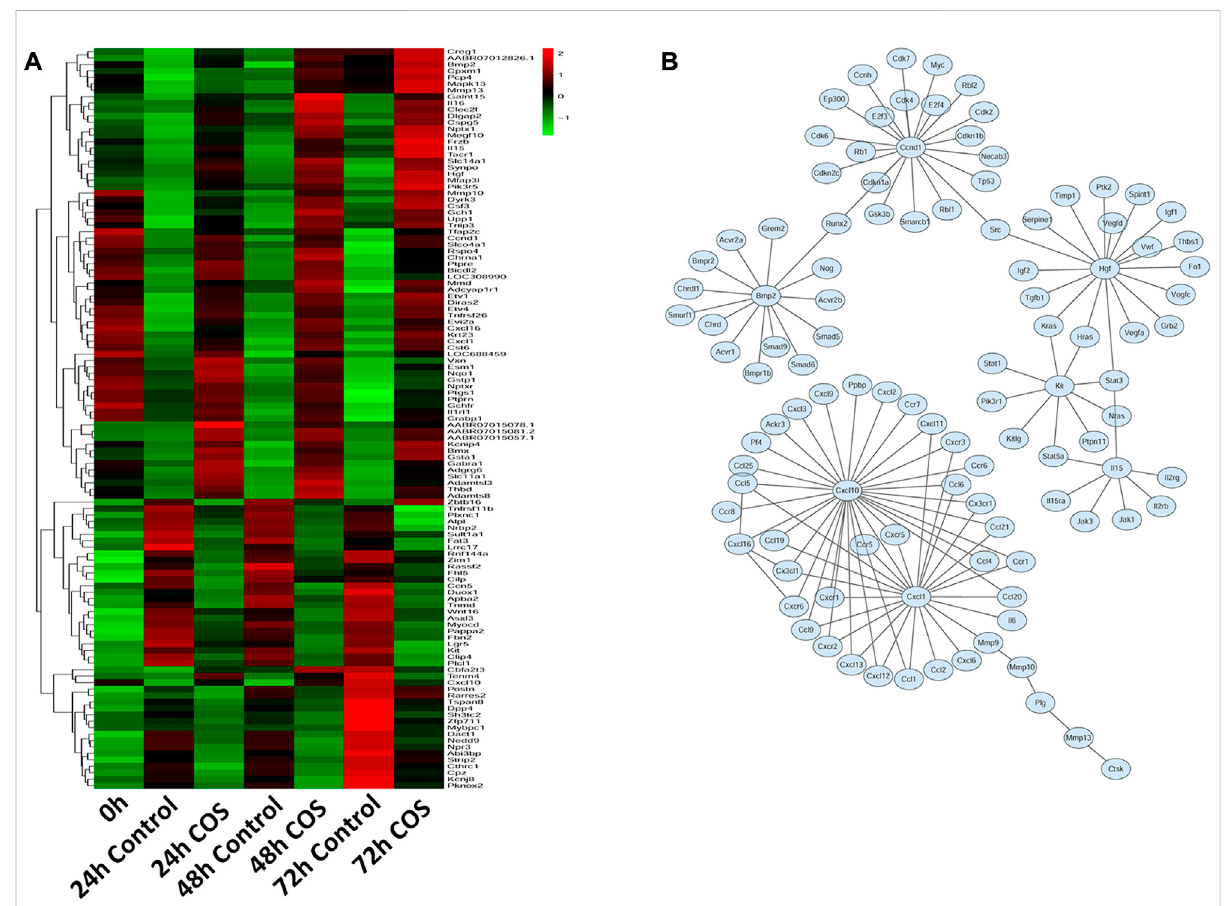
FIGURE 8 Expression pro fi les of gens in the COS-treated fi broblasts (A) Heatmap and clustering analysis of expression levels of DEGs at each time point. (B) Integrated regulatory network of genes inferred by integrating experimental data and computational